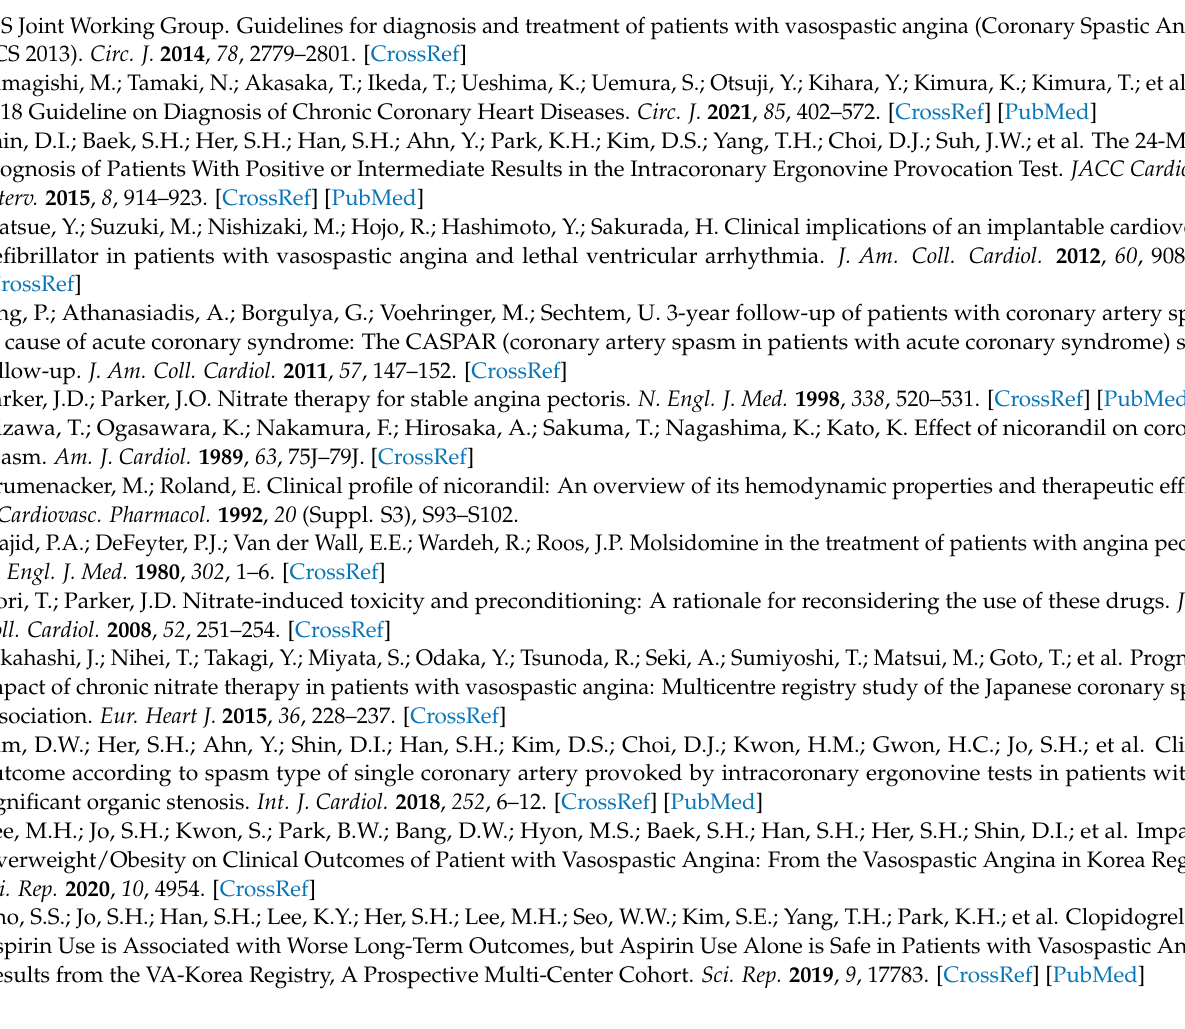
characteristics after propensity matching; Table S5: One-year clinical event rate of patients with good drug compliance; Table S6: One-year clinical event rate of patients with poor-compliance